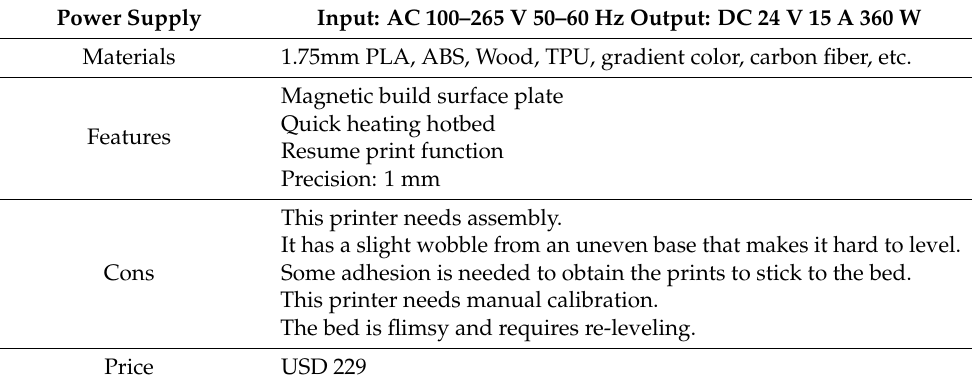
Table 4. Descriptions of Creality 3D Ender 3 Desktop 3D Printer. Power